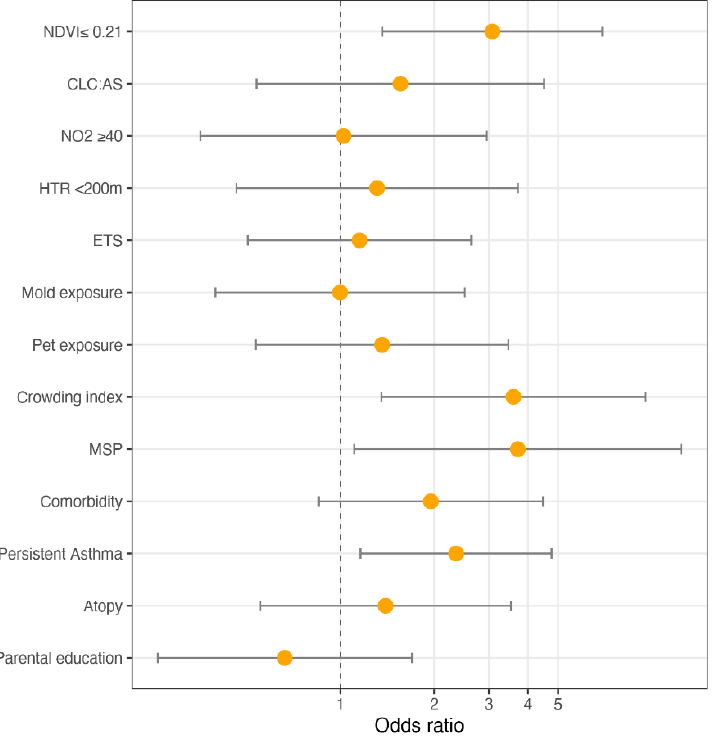
Figure 4. ORs and 95% CI of the mixed-effect logistic regression model for asthma control: a sensitivity analysis after missing values imputation.